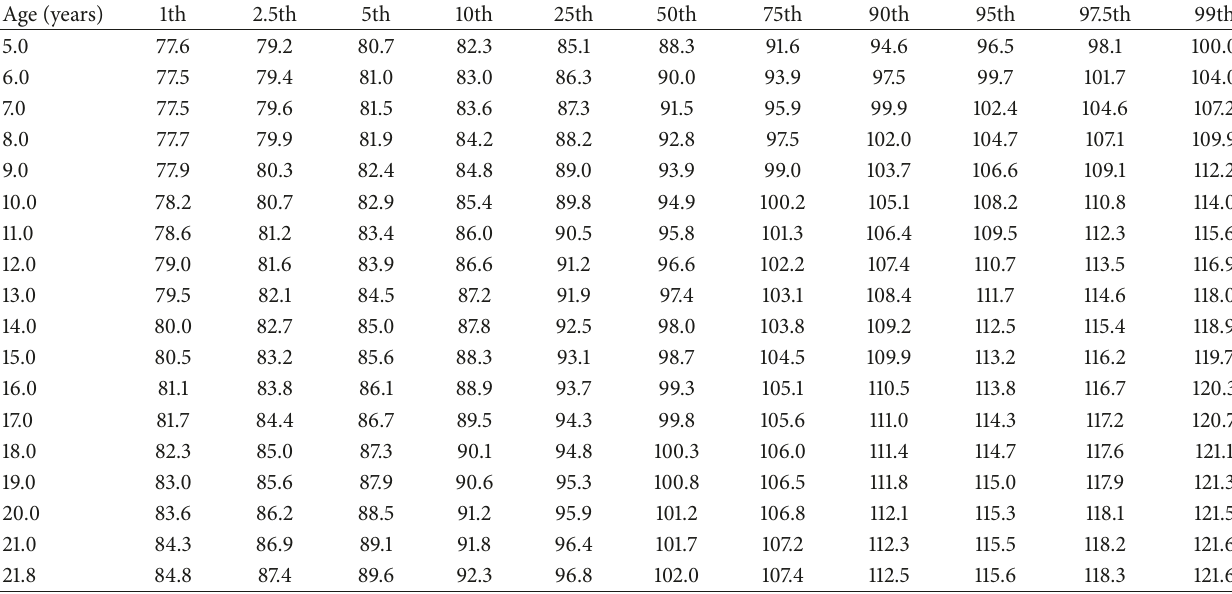
Table 4: Age-related reference intervals (RIs) for central (aortic) systolic blood pressure for the entire population ( 𝑛 = 1038